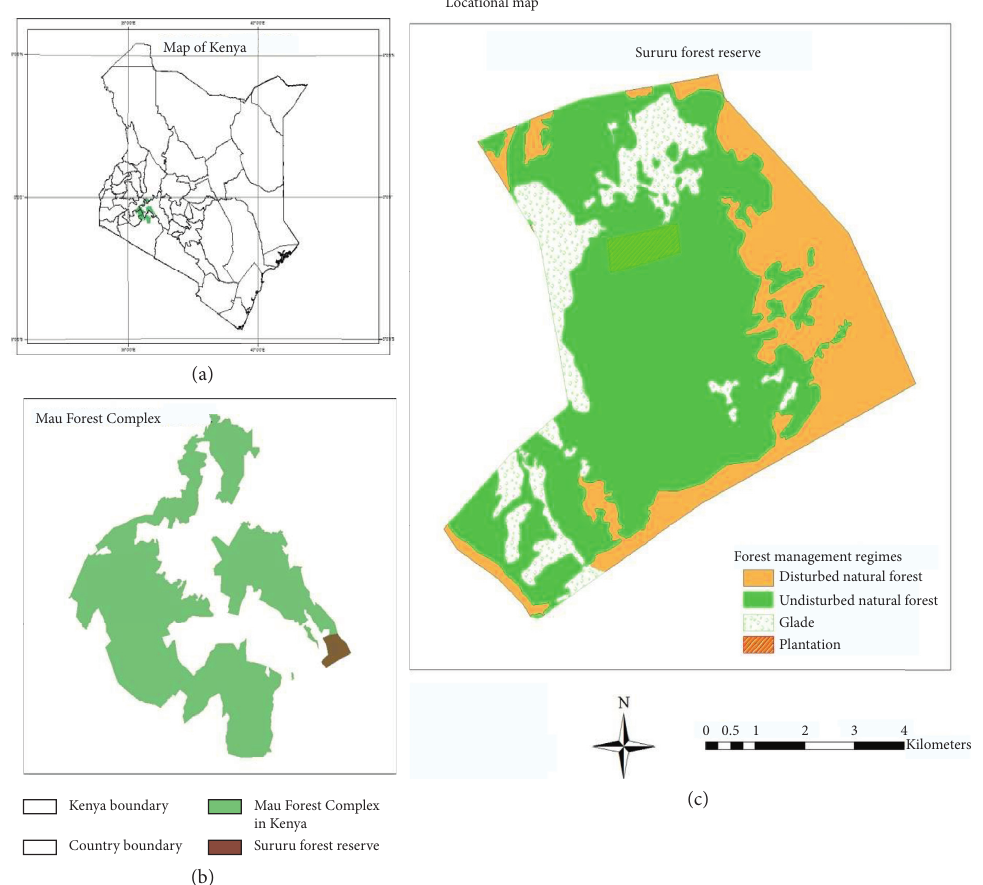
Figure 1: Map of the study area within Kenya (a), within Mau Forest Complex (b), and Sururu Forest